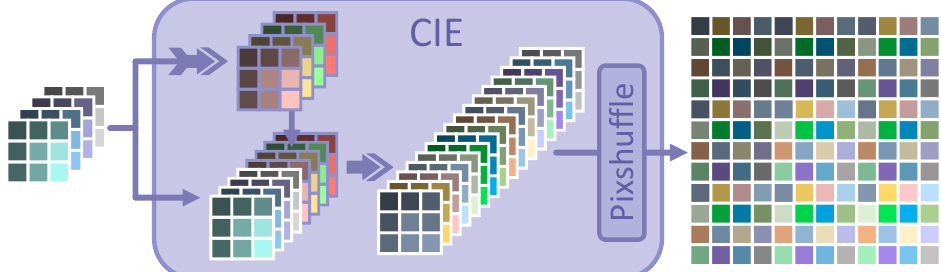
Figure 3. The pipeline of the CIE module. First, the fusion of measurements in the compressed domain is realized by 3 × 3 convolution (indicated by the purple arrow with tail) to obtain another Expanded Sampled Data ( ESD ), which is marked in a purple solid wireframe and is concatenated to the SD to maintain that the original measurements will not be averaged. Then, this fusion of SD and ESD , which is noted as EFSD , can be upsampled and reshaped in a way similar to that given in Figure